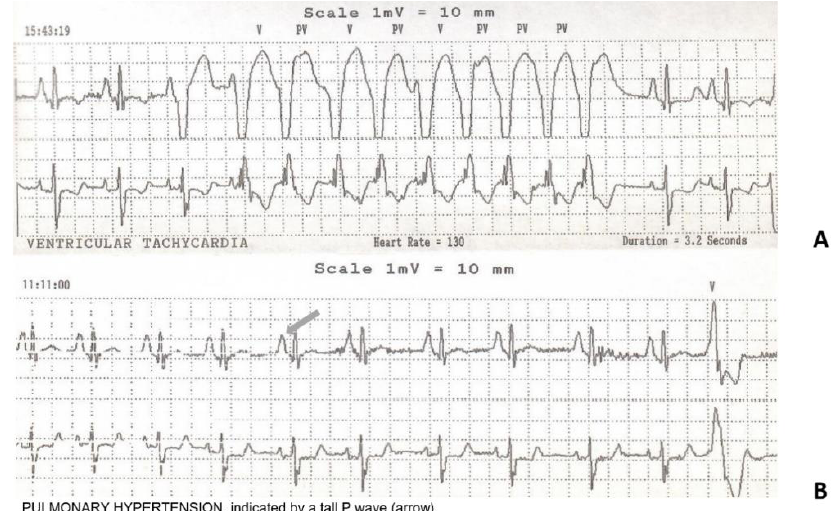
Figure 1. Cardiac Holter tracing. The record shows ventricular tachycardia with a heart rate of 130 bpm ( A ) and pulmonary hypertension highlighted by pulmonary P waves ( B ).